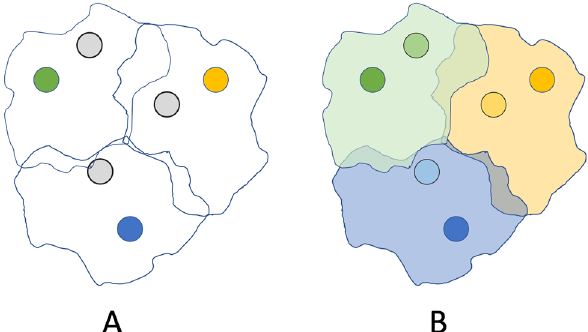
Figure 4. An illustrated example of transductive few-shot learning. ( A ) Grey circles represent unlabelled points (the query set) and coloured circles represent labelled points (the support set). ( B ) All unlabelled points are labelled based on their position within the labelled